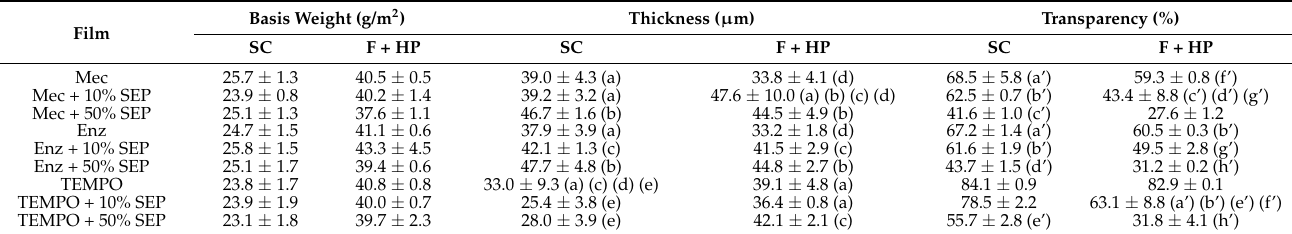
Table 2. Basis weight, thickness, and optical properties of the obtained